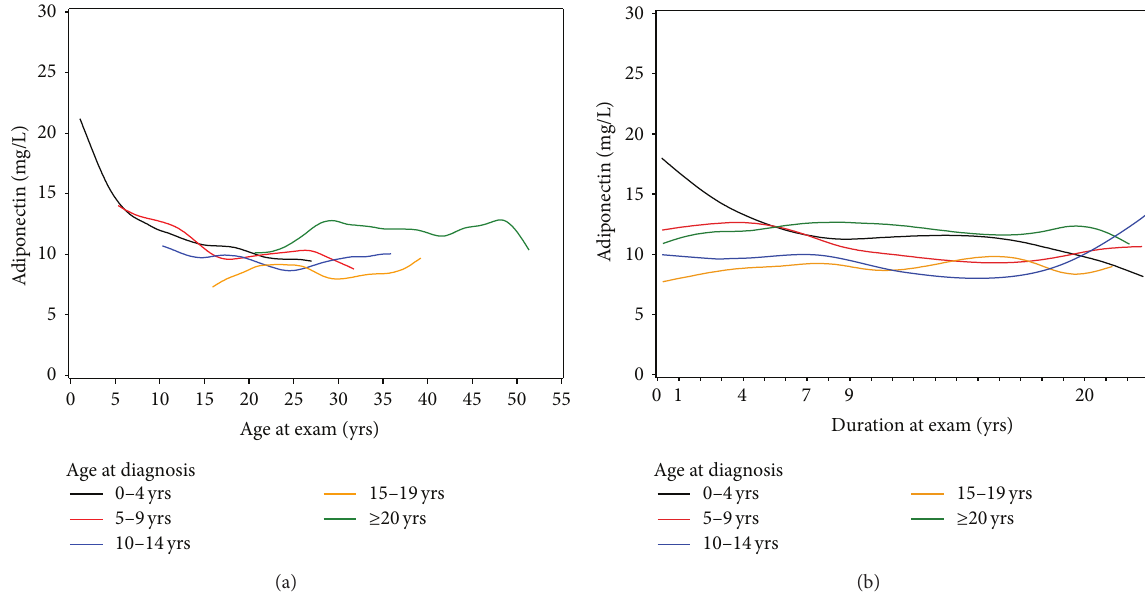
Figure 1: Adiponectin for age at diagnosis groups by (a) age and (b) diabetes duration at exam. Age at diagnosis groups 0–4, 5–9, 10–14, 15–19, and ≥ 20 years of